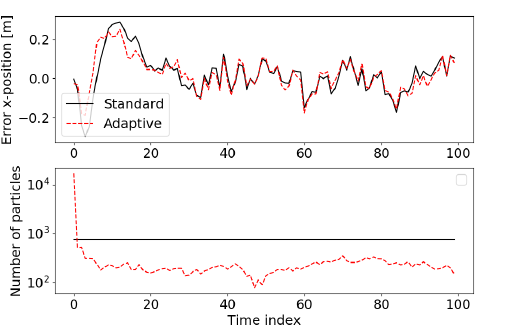
Figure 9. Example of how the adaptive particle filter achieves similar estimation accuracies ( top ) with a much lower number of particles ( bottom ). Black: standard particle filter, red: adaptive particle